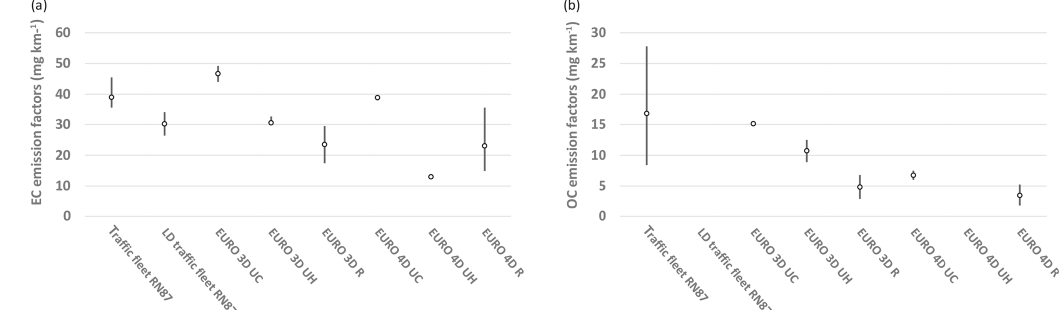
Figure 5. Emission factors for EC (a) and OC (b) for the mixed traffic fleet and the light-duty traffic of the RN87/E712 freeway and from the chassis dynamometer measurements of exhaust emissions of Euro 3 and Euro 4 vehicles for respectively urban cold (UC), urban hot (UH) and road (R) driving cycles. The emission factor for OC for the light-duty-traffic fleet could not be determined and no data are available for the hot driving conditions for the Euro 4 diesel